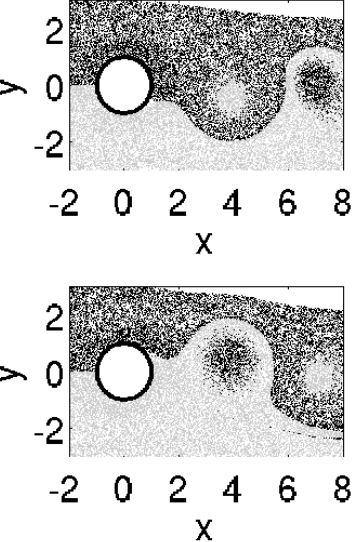
Fig. 12. Tracer released at the left boundary, black dots: tracer released at y > 0 , grey dots: tracer released at y < 0 . upper panel: t = 4 . 0 T c , lower panel: t = 4 . 5 T c .